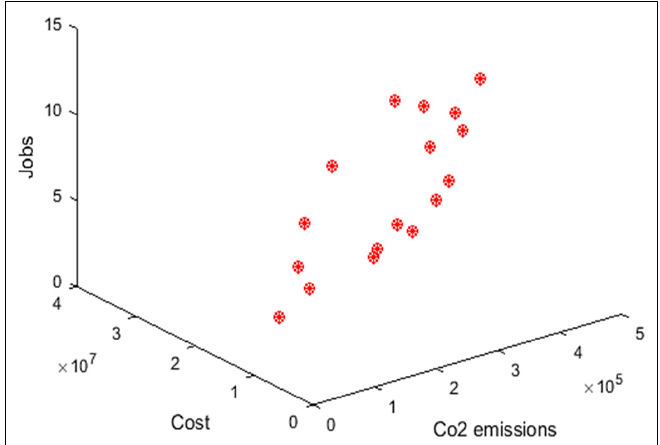
Figure 24. Pareto front of the first test problem from MOSA.